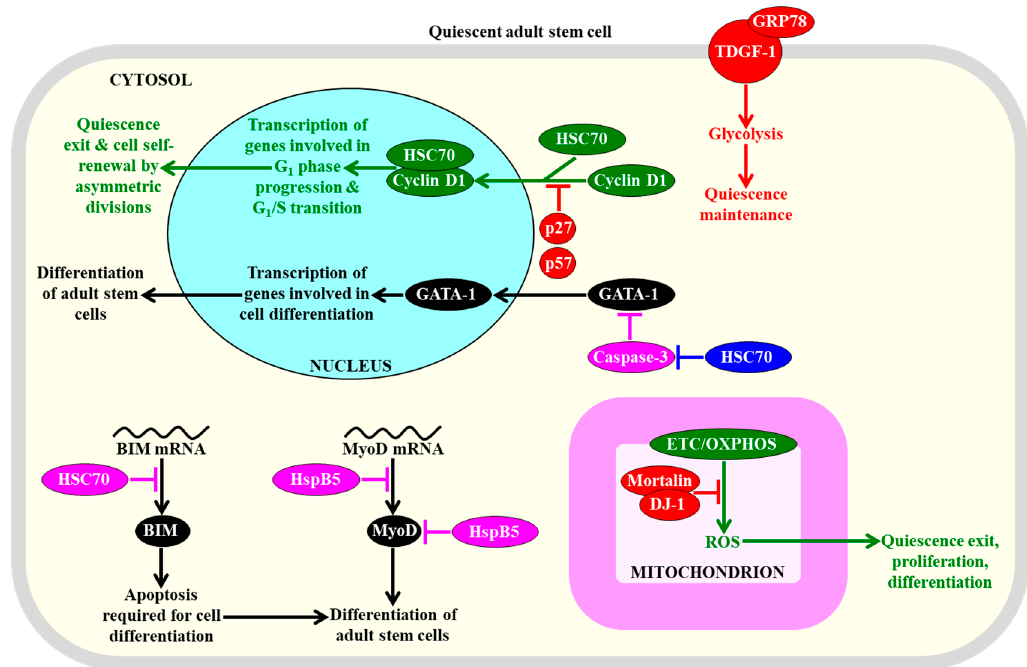
Figure 5. Several heat shock proteins (HSPs) play essential roles in preserving the quiescence, affecting the proliferation, and influencing the differentiation of adult stem cells. These HSPs control the nuclear import and degradation of some transcription factors, as well as the translation and stability of certain proteins that promote cell differentiation, glycolysis, and concentrations of mitochondrially-generated reactive oxygen species (ROS). Proteins, metabolites, and processes whose activities, concentrations, and rates must be increased to maintain the quiescence of adult stem cells are displayed in red. Proteins, metabolites, and processes whose activities, concentrations, and rates must be increased to promote the exit of adult stem cells from the state of quiescence are displayed in green. Proteins and processes whose activities and rates must be increased to promote the differentiation of adult stem cells are displayed in black. Proteins whose activities must be increased to suppress the differentiation of adult stem cells are displayed in pink. See text for more details. Abbreviations: BIM, Bcl-2-like protein 11; GATA-1, GATA-binding factor 1; GRP78, immunoglobulin heavy chain-binding protein homolog; HSC70, heat shock cognate 71 kDa protein; HspB5, alpha-crystallin B chain; MyoD, myoblast determination protein D; TDGF-1, teratocarcinoma-derived growth factor